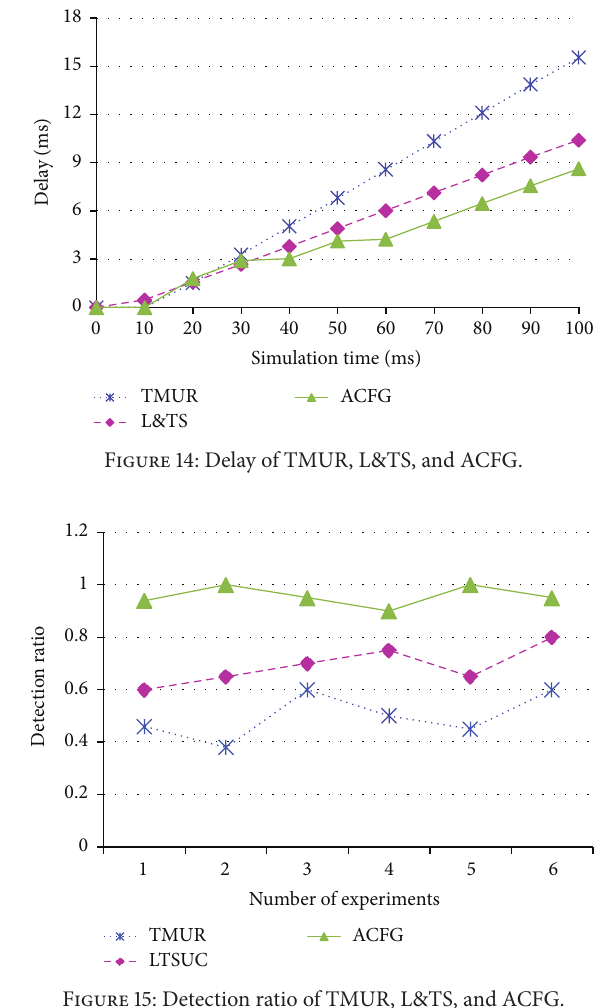
Figure 15: Detection ratio of TMUR, L&TS, and ACFG.